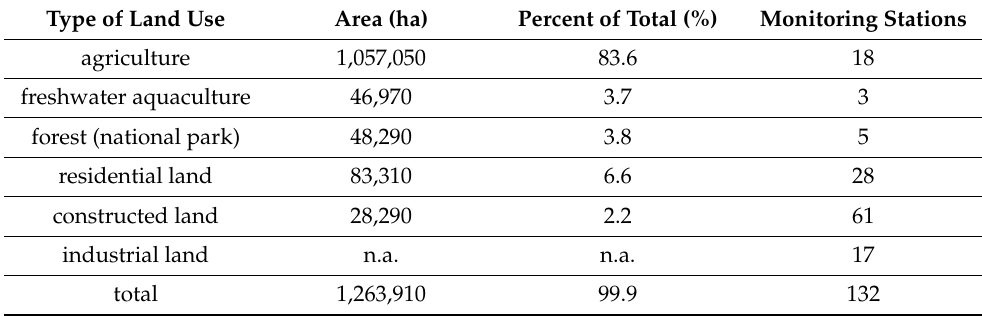
Table 1. Investigated land use types of freshwater land use within the project area of the VMD. Type of Land Use Area (ha) Percent of Total (%) Monitoring